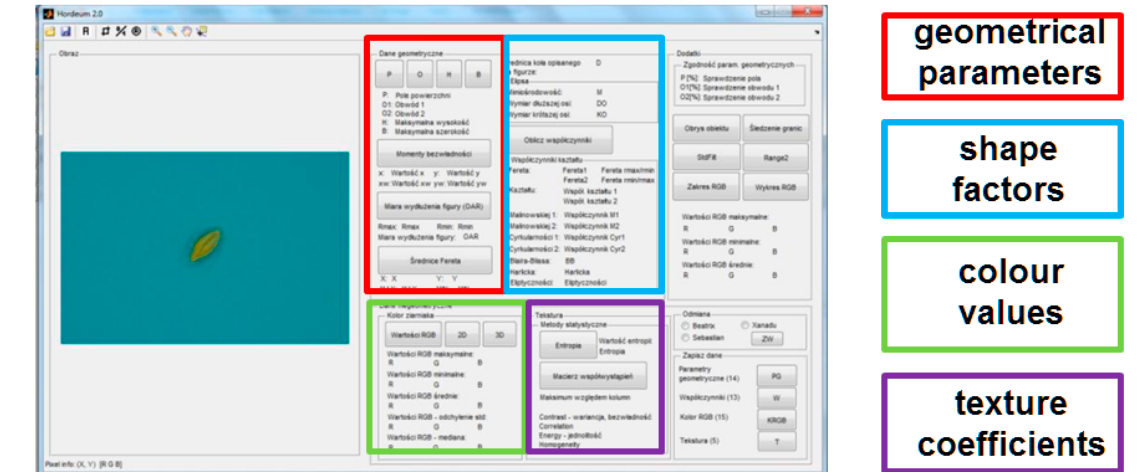
Figure 3. The structure of “ Hordeum 2.0” software with four graphic descriptor groups.